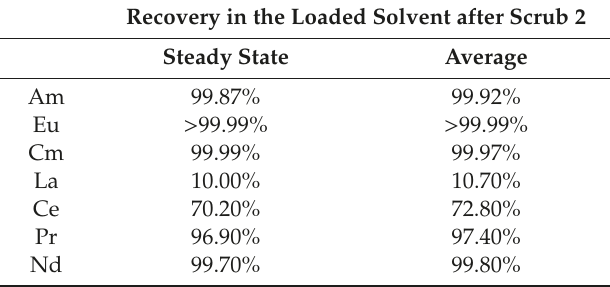
Table 3. Predicted recovery into solvent exiting Scrub 2